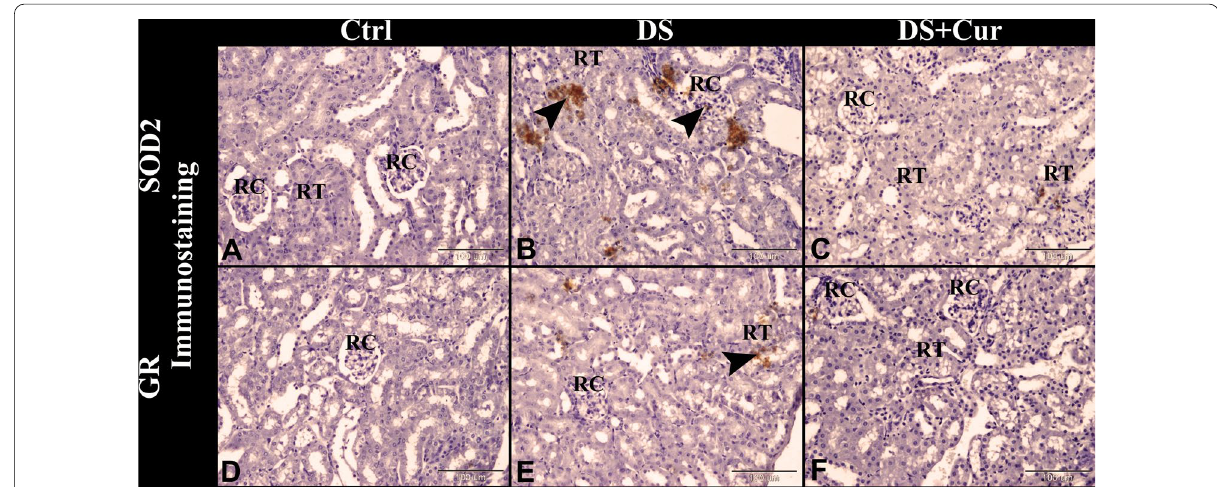
Fig. 7 Photomicrograph of superoxide dismutase 2 (SOD2) (A–C) and glutathione reductase (GR) (D–F) immunostaining in the kidney. A The kidney of control (Ctrl) group showed slight SOD2 immunostaining in the renal corpuscles (RC) and tubules (PT). B The kidney of diclofenac sodium (DS) group showed mild SOD2 immunoexpression (arrowheads) in the renal corpuscles (RC) and tubules (PT). C The kidney of diclofenac sodium curcumin (DS Cur) group showed slight SOD2 immunostaining in the renal corpuscles (RC) and tubules (PT). D The kidney of Ctrl group + + showed slight GR immunostaining in the renal corpuscles (RC) and tubules (PT). E The kidney of DS group showed mild GR immunoexpression (arrowheads) in the renal corpuscles (RC) and tubules (PT). F The kidney of DS Cur group showed slight GR immunostaining in the renal + corpuscles (RC) and tubules (PT). Original magnification, X200, scale bar